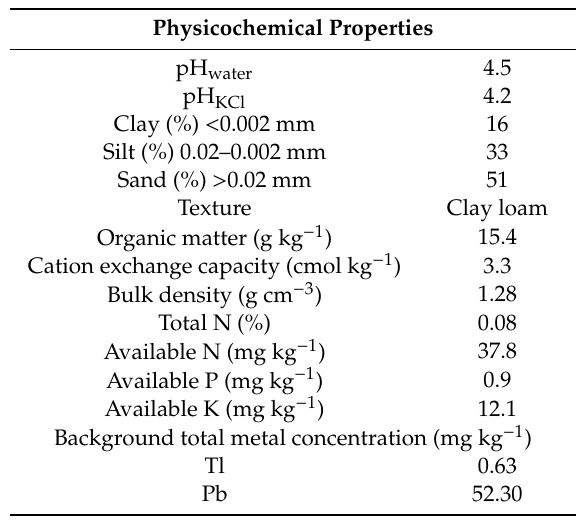
Table 1. Soil physicochemical properties in the present